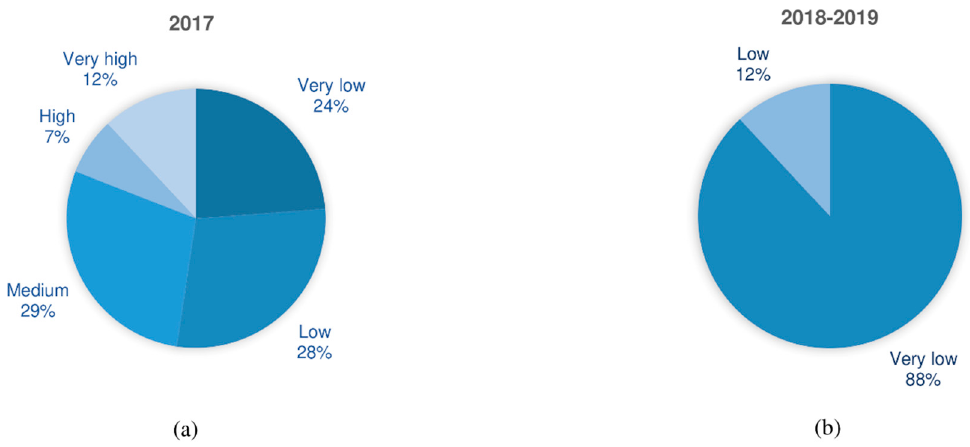
Figure 7. Percentages of the road segments with risk levels: ( a ) before installation of speed cameras; ( b ) after installation of speed cameras.